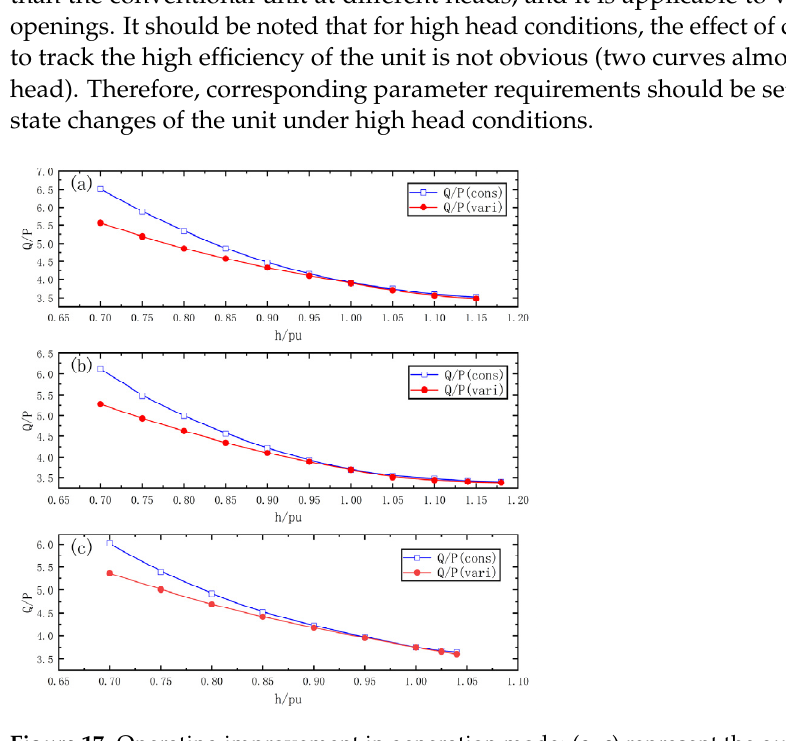
Figure 17. Operating improvement in generation mode: ( a – c ) represent the guide openings of 42%, 63%, and 84%, respectively.